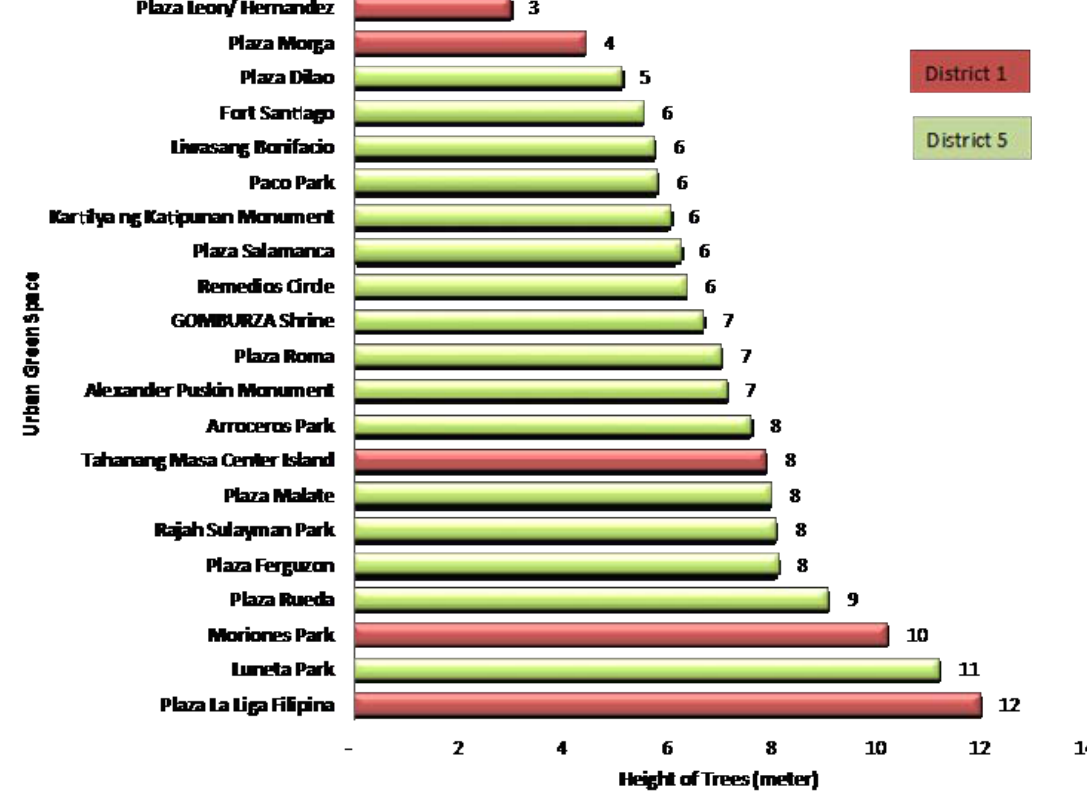
Figure 8. Average height of trees in surveyed urban green